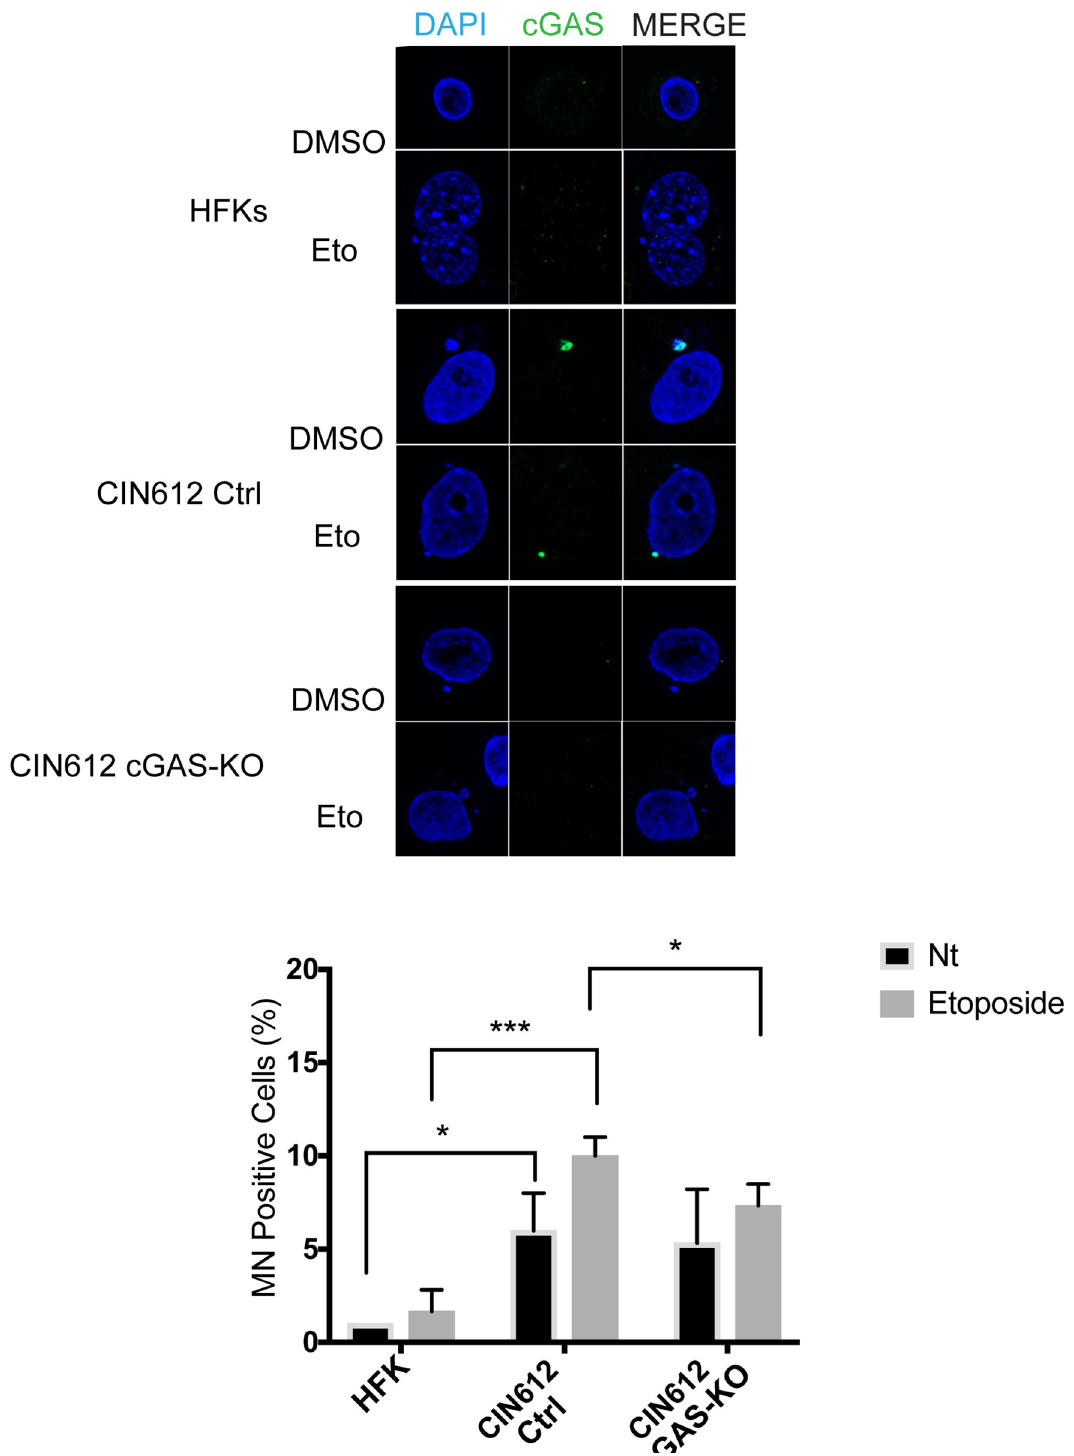
Fig 7. cGAS localizes in DNA damage induced micronuclei. Micronuclei formation in HPV positive cells and cGAS co-localization (left panel) post etoposide treatment for 24hrs at 50 μ M. Quantitation of micronuclei from three independent experiments and two different clones of CIN612 pLenti control or cGAS-KO (right panel). Analysis was performed on 100 cells for each condition. Statistical analysis: two-tailed unpaired T-test; p < 0.05 indicates significance compared to the respective sample group. Where ( � ) < 0.05 and ( ��� ) <